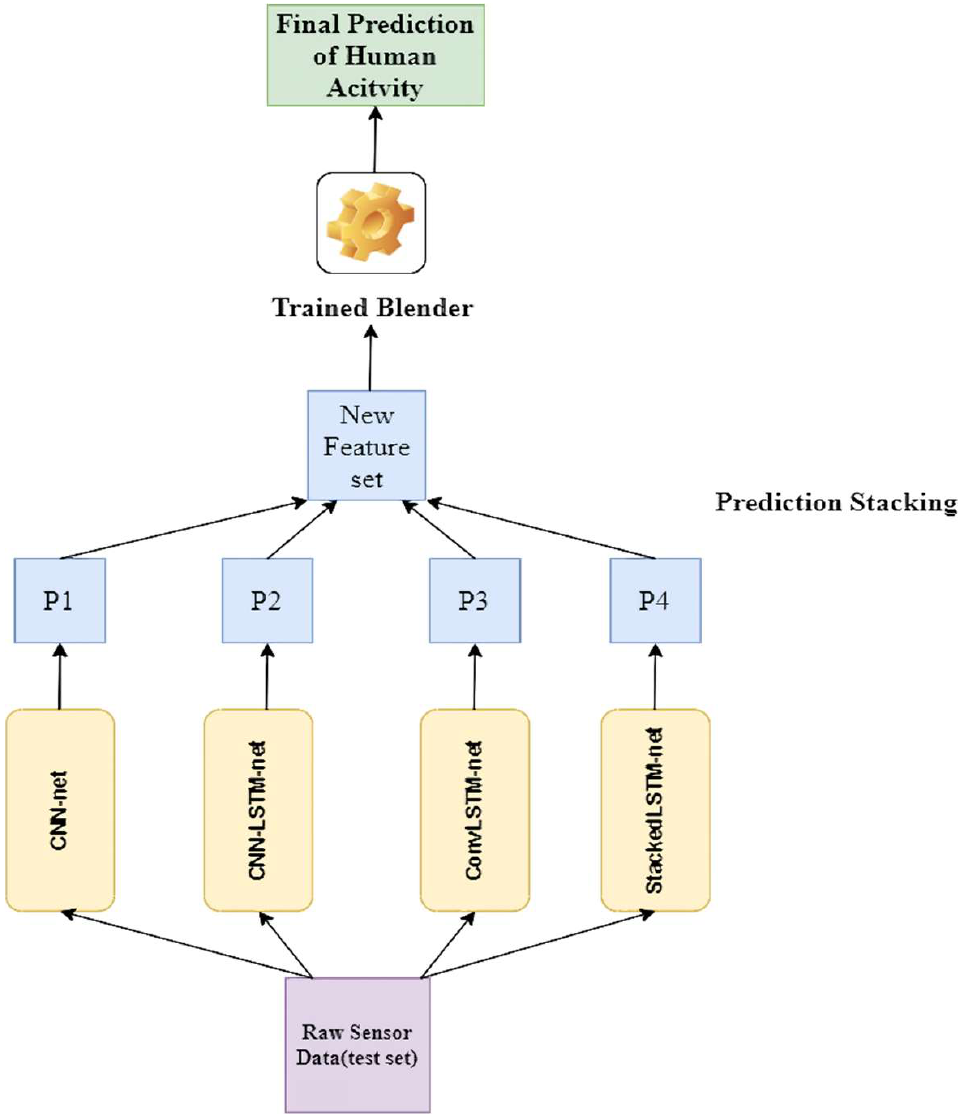
Figure 9. The architectural overview of our proposed Ensem-HAR model. From the above discussion of how our proposed Ensem-HAR model works, it can be seen that the proposed Ensem-HAR model is not a stand-alone model; instead, it is a combination (technically called an ensemble) of four deep learning classifiers. Thus, the errors made in prediction by any particular classifier can be neutralized by other classifiers in the final ensemble. The main factor to be considered here is that the classifiers should be distinct enough that that they exhibit different characteristics in their predictions, and hence can complement each other’s errors, which in turn lead to higher final recognition accuracy in predicting human